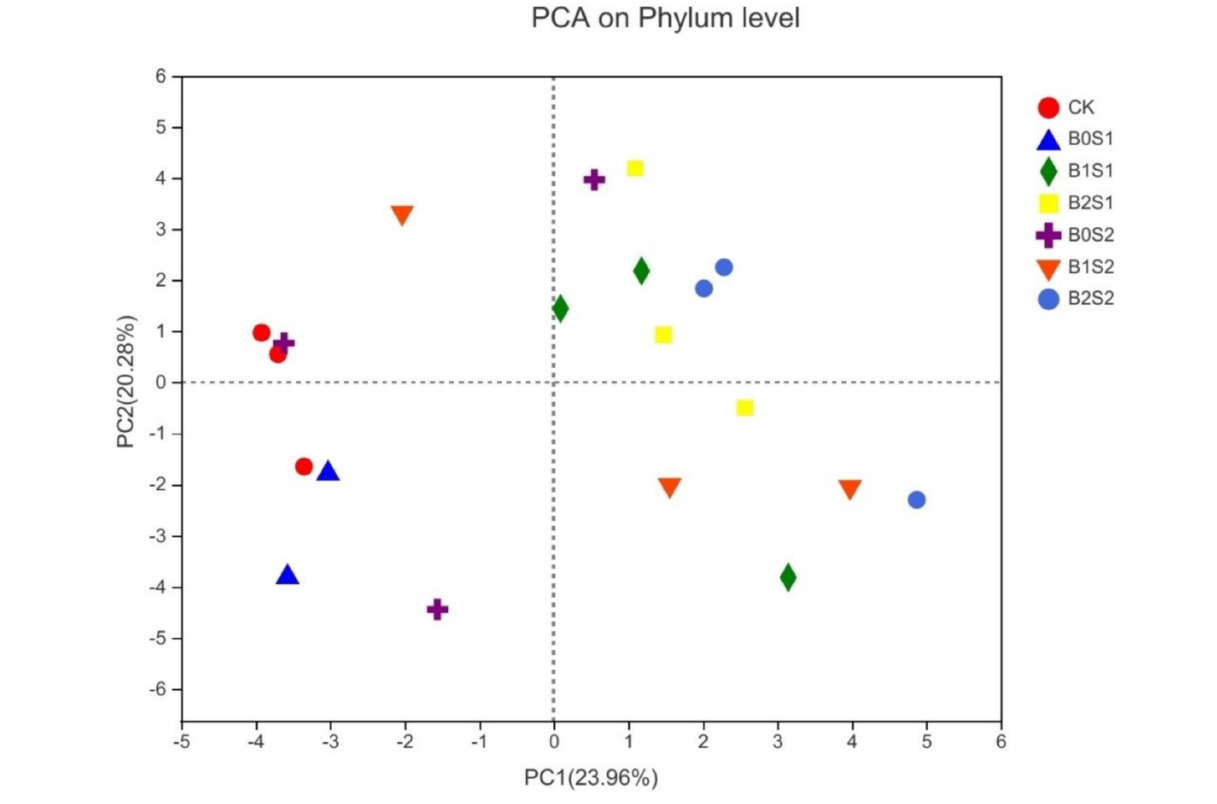
FIGURE 4 | Principal component analysis for microbial communities of soil amended with biochar and non-biochar. Data are presented mean; CK = control, B0S1, B1S1, B2S1, B0S2, B10S2, and B2S2 = 0, 15, and 30 g biochar + 0.5 and 1 g salt g kg − 1